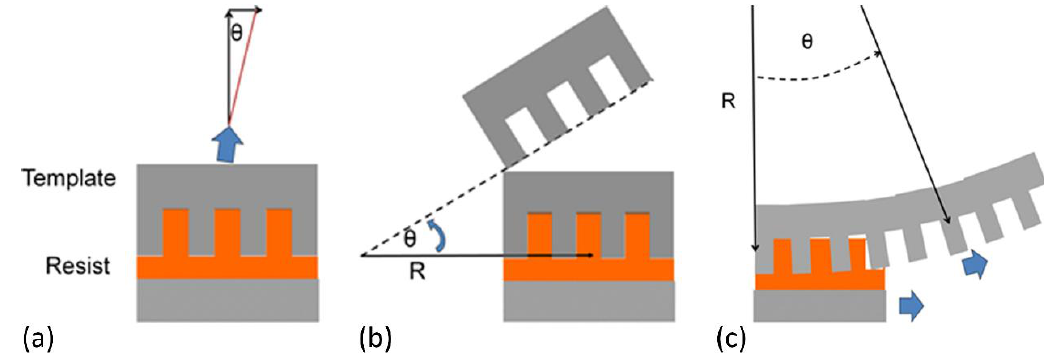
Figure 5. Schematics of demolding process for various release processes: ( a ) lift-off; ( b ) peeling; ( c ) roll-to-roll. Reprinted with permission from [55]. Copyright 2013 American Vacuum Society.